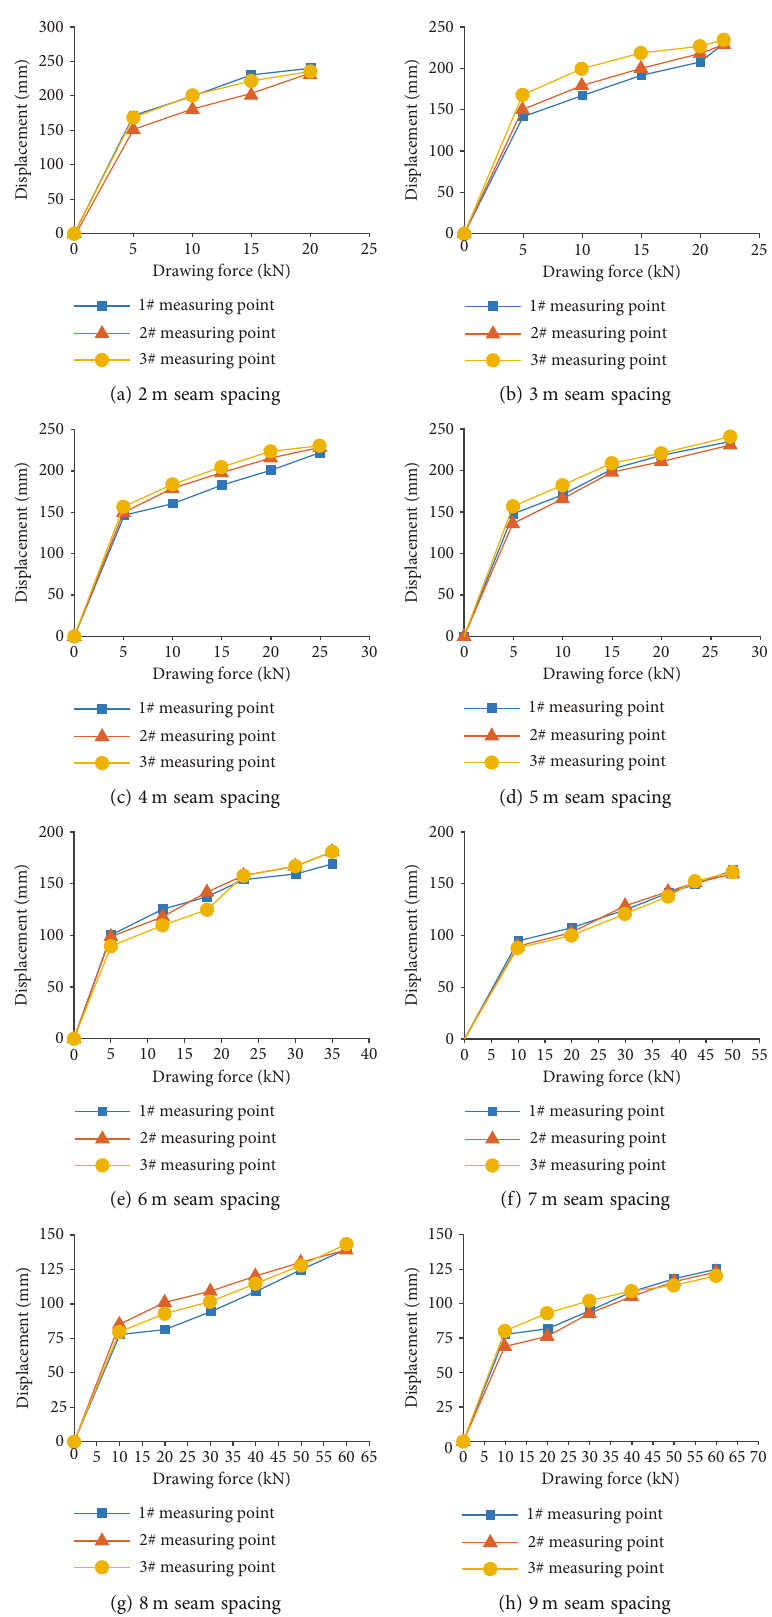
Figure 6: Drawing force-displacement curve of test rock